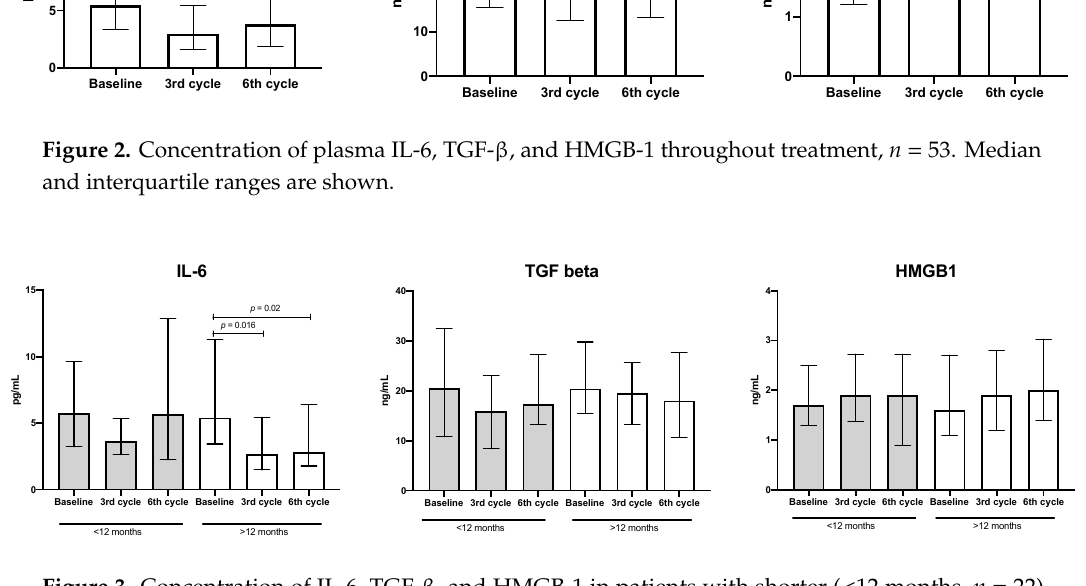
Figure 2. Concentration of plasma IL-6, TGF- β , and HMGB-1 throughout treatment, n = 53. Median and interquartile ranges are shown.